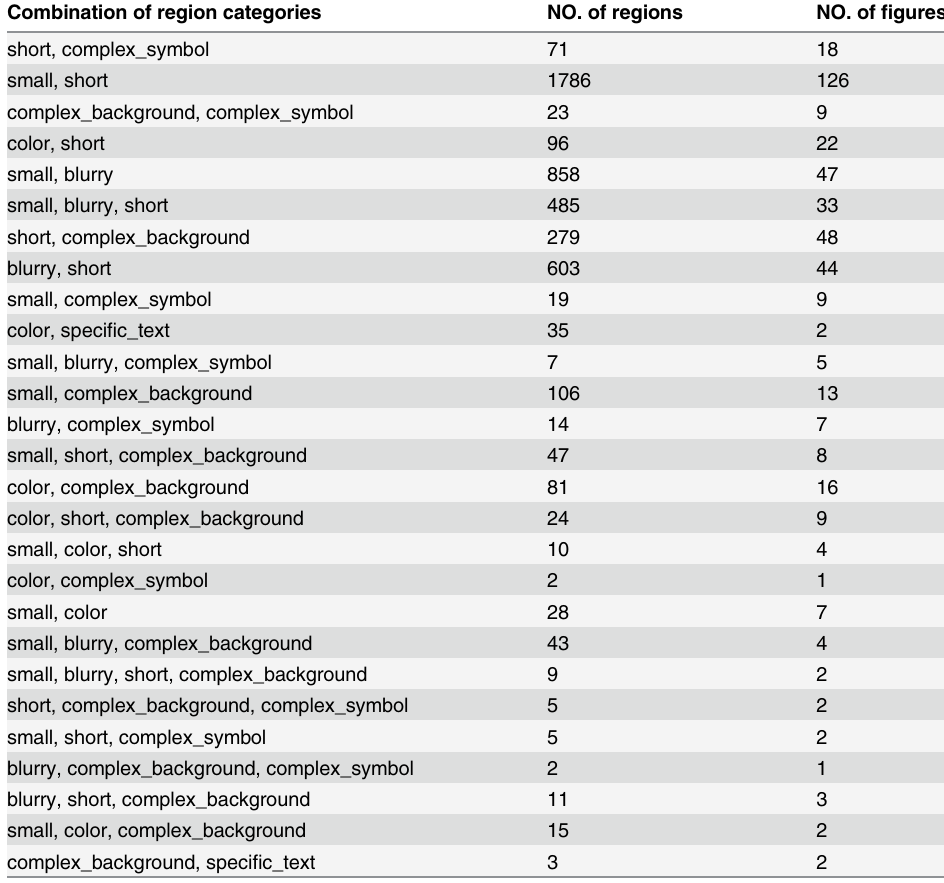
Table 3. Statistics of text (word) regions and figures with combination of categories. Combination of region